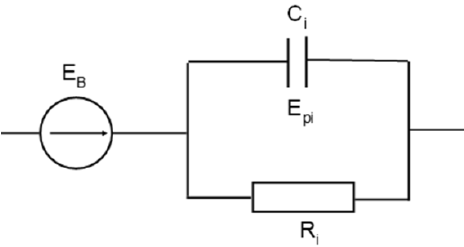
Figure 8. Electrical equivalent circuit for an acid battery.